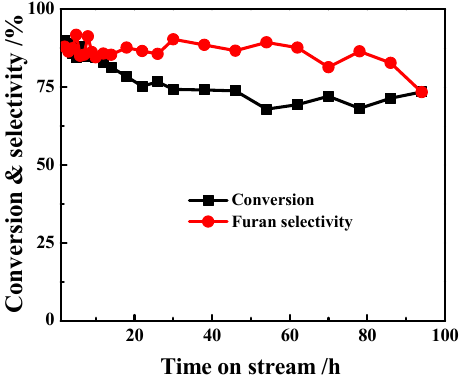
Figure 7. Stability of the 1%Pt / SBA-15 pH = 6C catalyst in furfural decarbonylation (reaction conditions: 573 K, WHSV = 16.5 h − 1 , H 2 / furfural (mol) = 2.4).